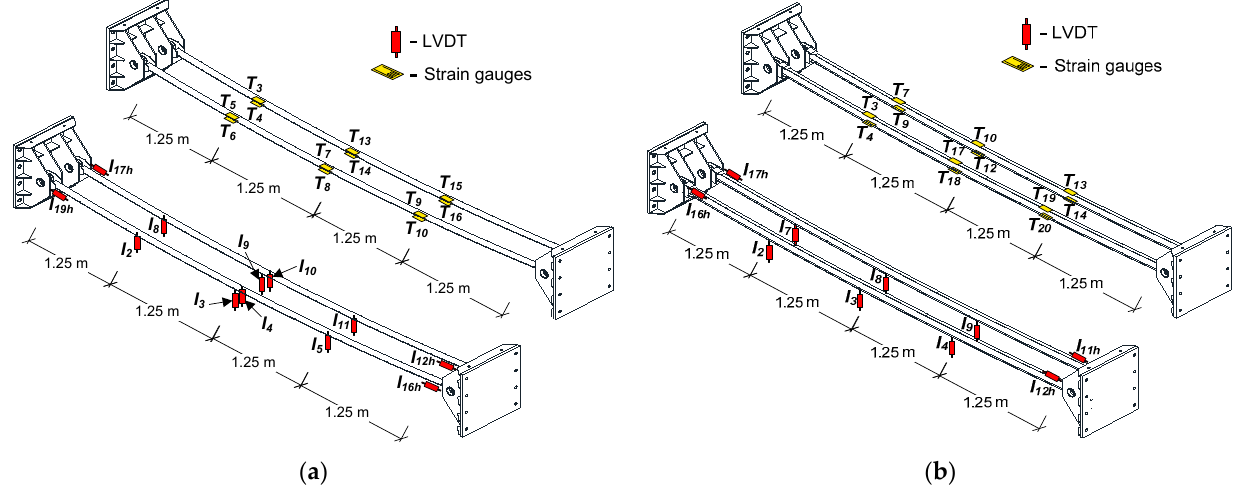
Figure 5. The monitoring devices’ layout: ( a ) prototype with flexible bands ( Model-1 ); ( b ) prototype with flexural-stiff ribbon-profiles ( Model-2 ).